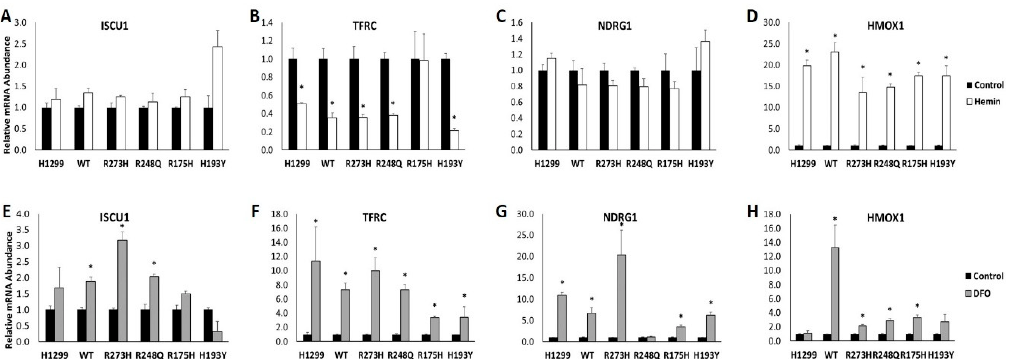
Figure 3. Impact of mutant TP53 expression on iron-dependent changes in gene expression. Relative mRNA expression of ( A ) iron–sulfur cluster assembly enzyme 1 (ISCU1), ( B ) transferrin receptor 1 (TFRC), ( C ) NMYC downstream regulated gene 1 (NDRG1), and ( D ) heme oxygenase 1 (HMOX1) in TP53 null H1299 cells (H1299) or H1299 cells transfected with wild-type (WT) TP53, or the indicated mutant TP53 following treatment with DMSO (control) or 40 μ M hemin for 48 h. Relative mRNA expression of ( E ) ISCU1, ( F ) TFRC, ( G ) NDRG1, and ( H ) HMOX1 in the cells described above following treatment with DMSO (control) or 50 μ M desferrioxamine (DFO) for 48 h. * Denotes statistical significance from respective controls, p < 0.05.